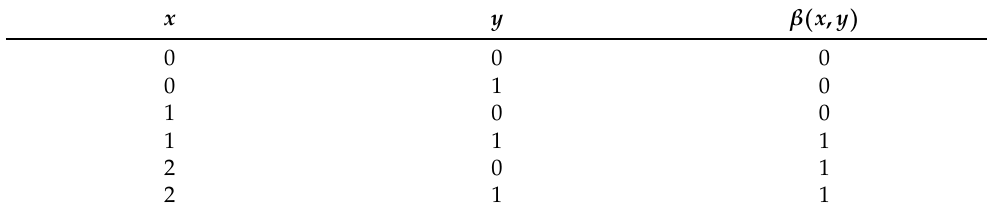
Table 2. The binary β